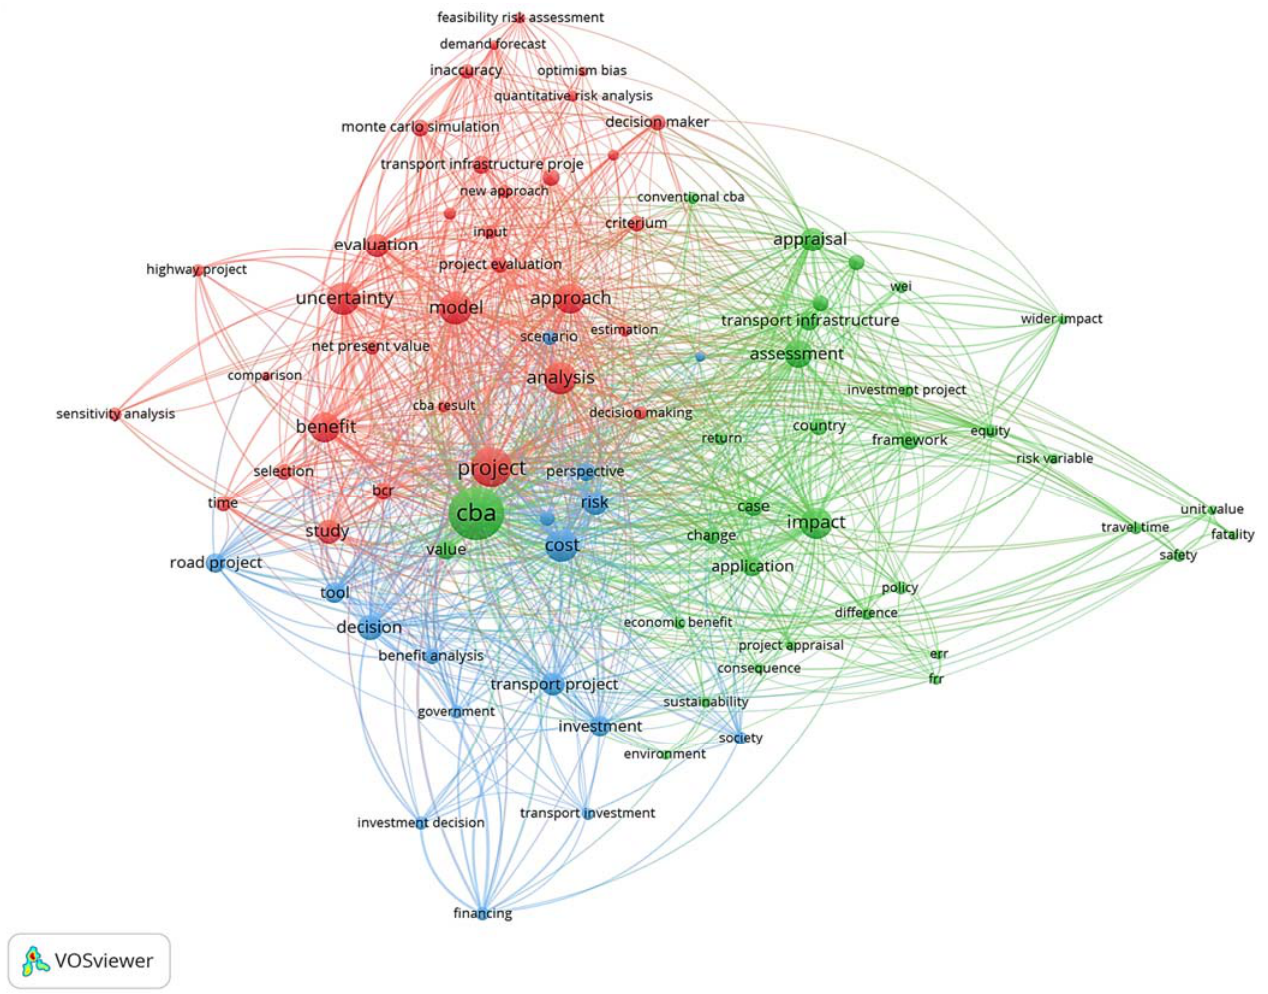
Figure 2. Three main research areas identified via VOSViewer map: (1) A comprehensive framework of individual parts of CBA approach (green cluster); (2) Approaches for incorporating uncertainty within conventional CBA (red cluster); (3) CBA as a decision tool within road project appraisal (blue cluster).